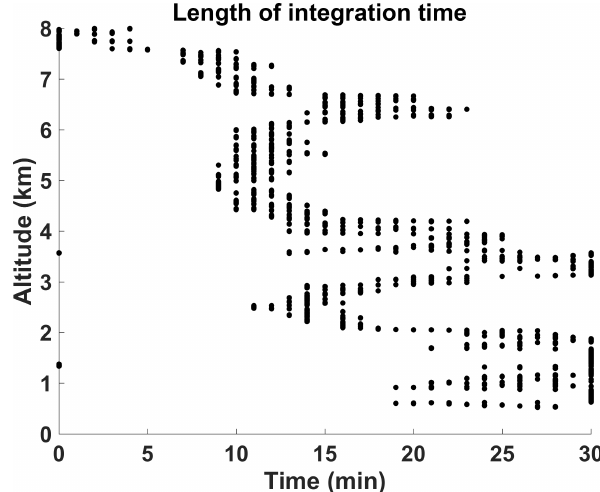
Figure 2. Example integration times from 22 July 2015. The lidar water vapour integration period is determined by the length of time the air parcels spend inside the homogeneous region. The integra- tion time will decrease with altitude due to higher wind speeds. The maximum integration time is 30min, in order to properly compare with the traditional